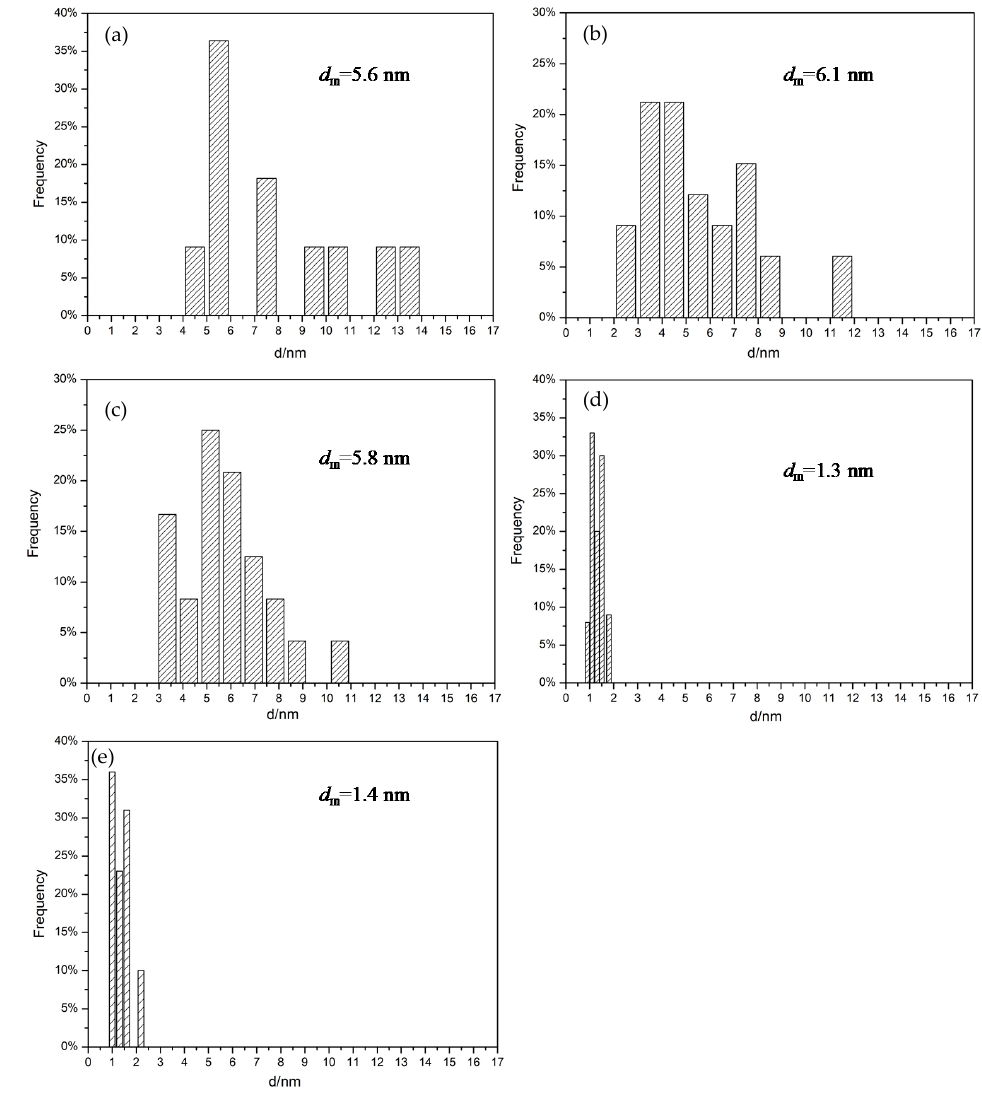
Figure 6. Pd particle-size distributions of synthesized catalysts: ( a ) 0.2% Pd/SiO 2 ; ( b ) 0.2% Pd-AlPO-5/SiO 2 ; ( c ) 0.2% Pd-AlPO-8/SiO 2 ; ( d ) 0.2% Pd-AlPO-11/SiO 2 ; ( e ) 0.2% Pd-AlPO-31/SiO 2.